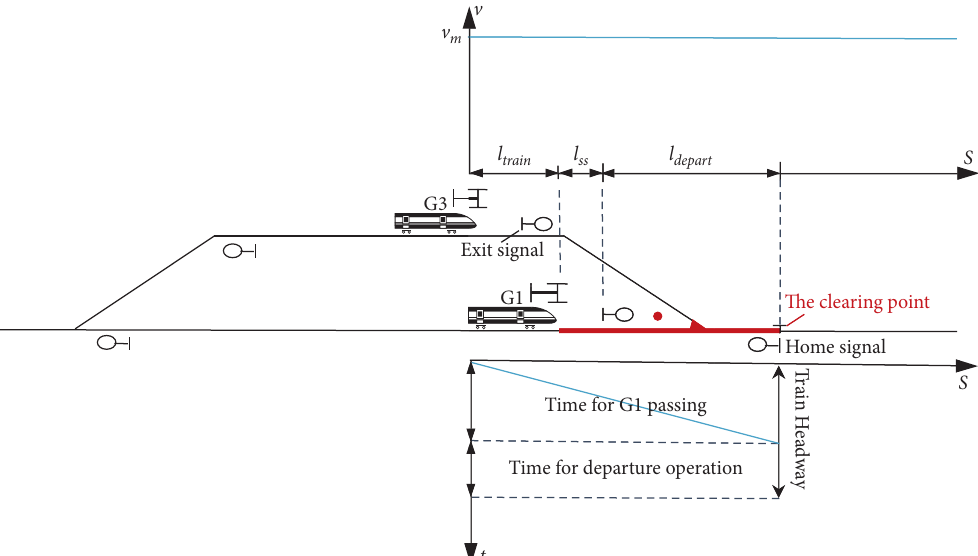
Figure 9: G1 passes through and the rear G3 departs from the station.